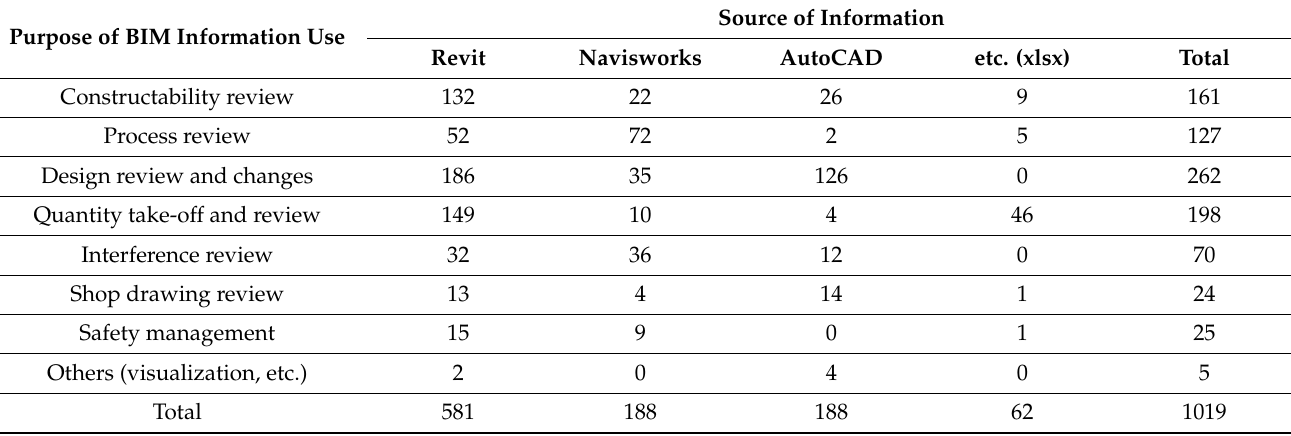
Table 2. Classification of information sources for the BIM RFIs by purpose of information